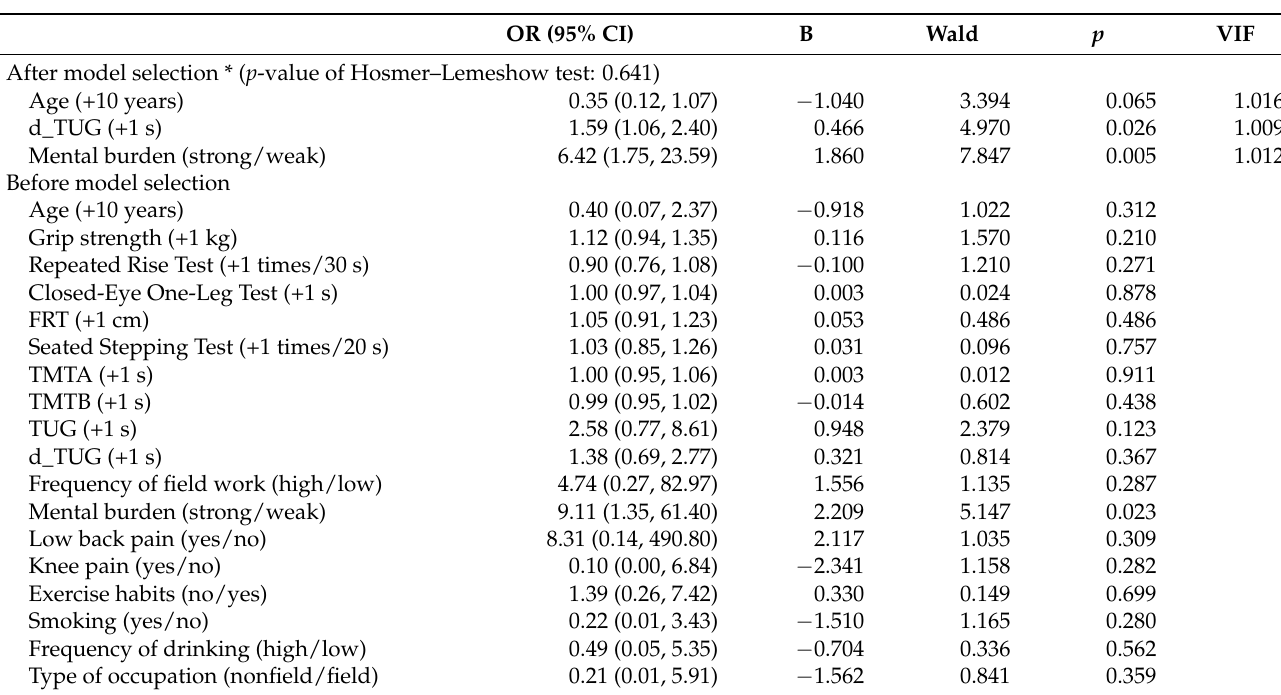
Table 7. Odds ratios and 95% confidence intervals for stumbling after and before model selection in women. OR (95% CI) B